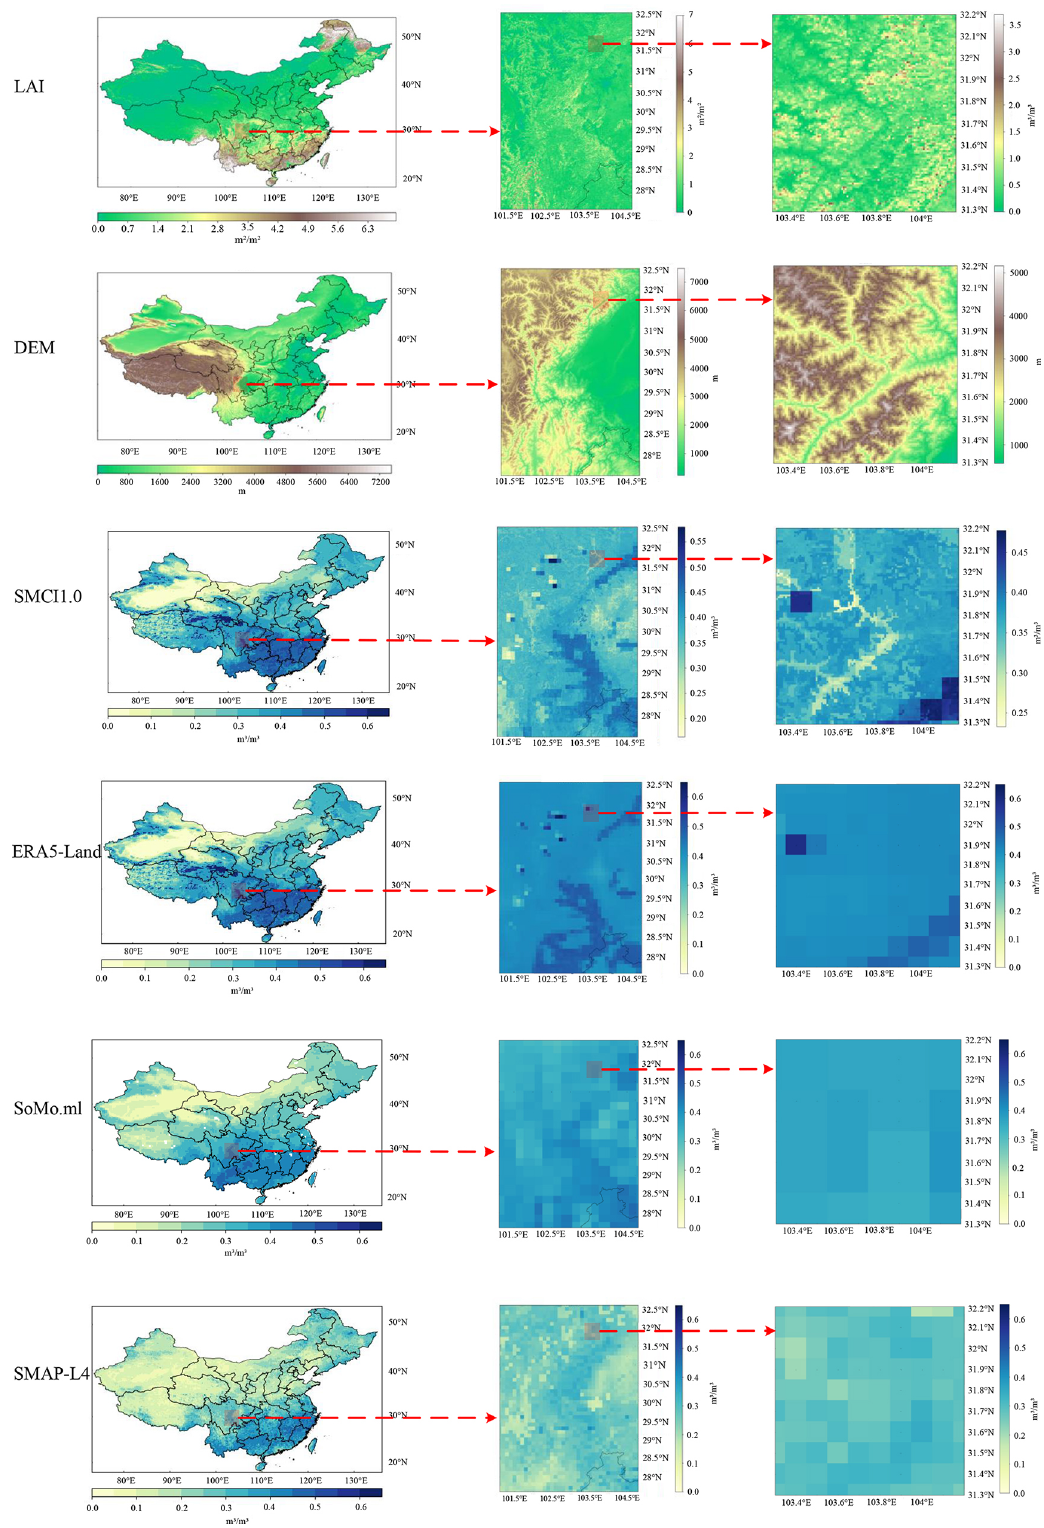
Figure 7. Soil moisture maps from different products on 1 January 2016. The resolution is 1km for SMC1.0, 9km for ERA5-Land and SMAP-L4, and 0.25 ◦ for